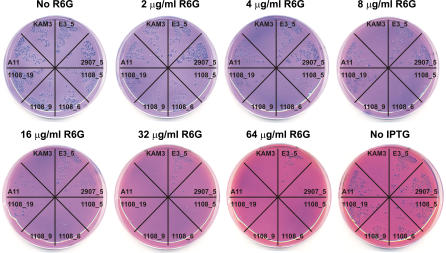
Phenotype of E. coli XL1-Blue Strain Expressing the Selected Inhibitory DARPinsSix AcrB inhibitors (2907_5, 1108_5, 1108_6, 1108_9, 1108_19, and A11), one unselected nonbinding DARPin (E3_5), and an acrB knockout strain (KAM3 [14], transformed also with E3_5) were ranked for their R6G sensitivity. Induction of the DARPins results in the inhibition of AcrB, yielding an R6G-sensitive phenotype. E. coli cells were transformed with the respective plasmid and plated under different conditions: nonselective, no R6G or no IPTG; selective where different R6G concentrations create an environment in which inhibitory DARPins repress growth. All plates contained IPTG (except plate no IPTG). The plates were colored with Coomassie brilliant blue for better visibility of the colonies.